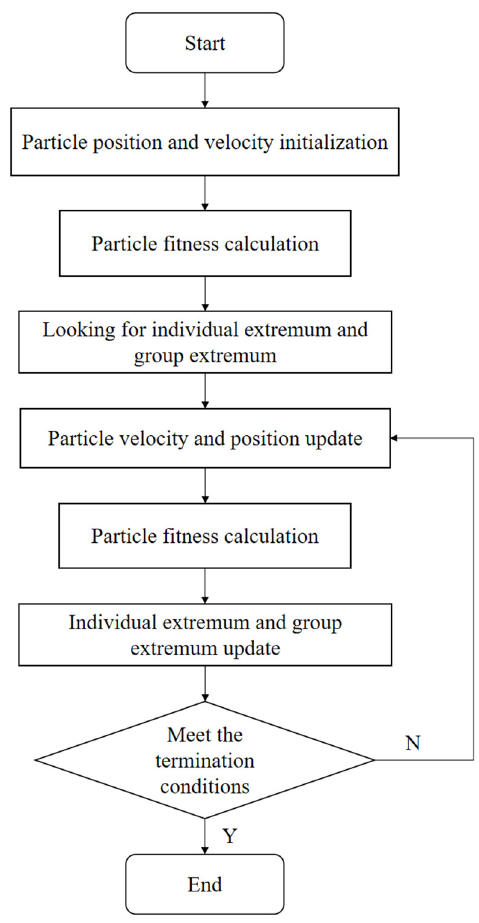
Figure 7. PSO optimization algorithm process.